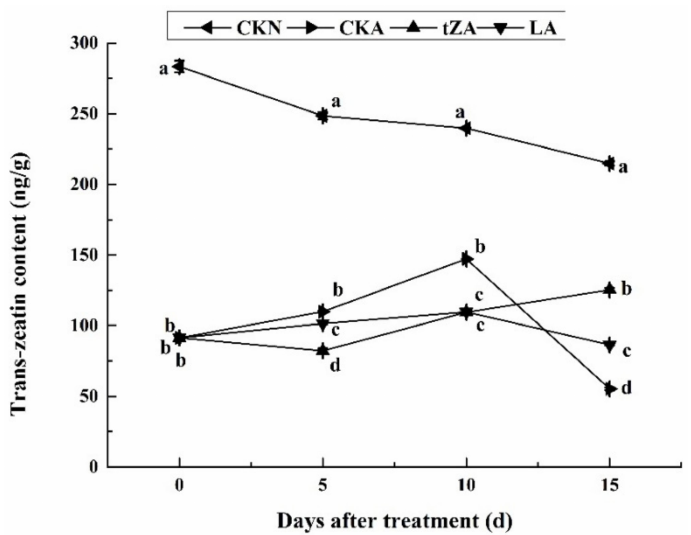
Figure 5. The Changes of trans-zeatin content in CKN, CKA, tZA and LA groups after treatment. Different lower-case letters among different treatment groups indicate significant differences based on one-way analysis of variance in SPSS 21.0 followed by the Duncan’s test ( p <